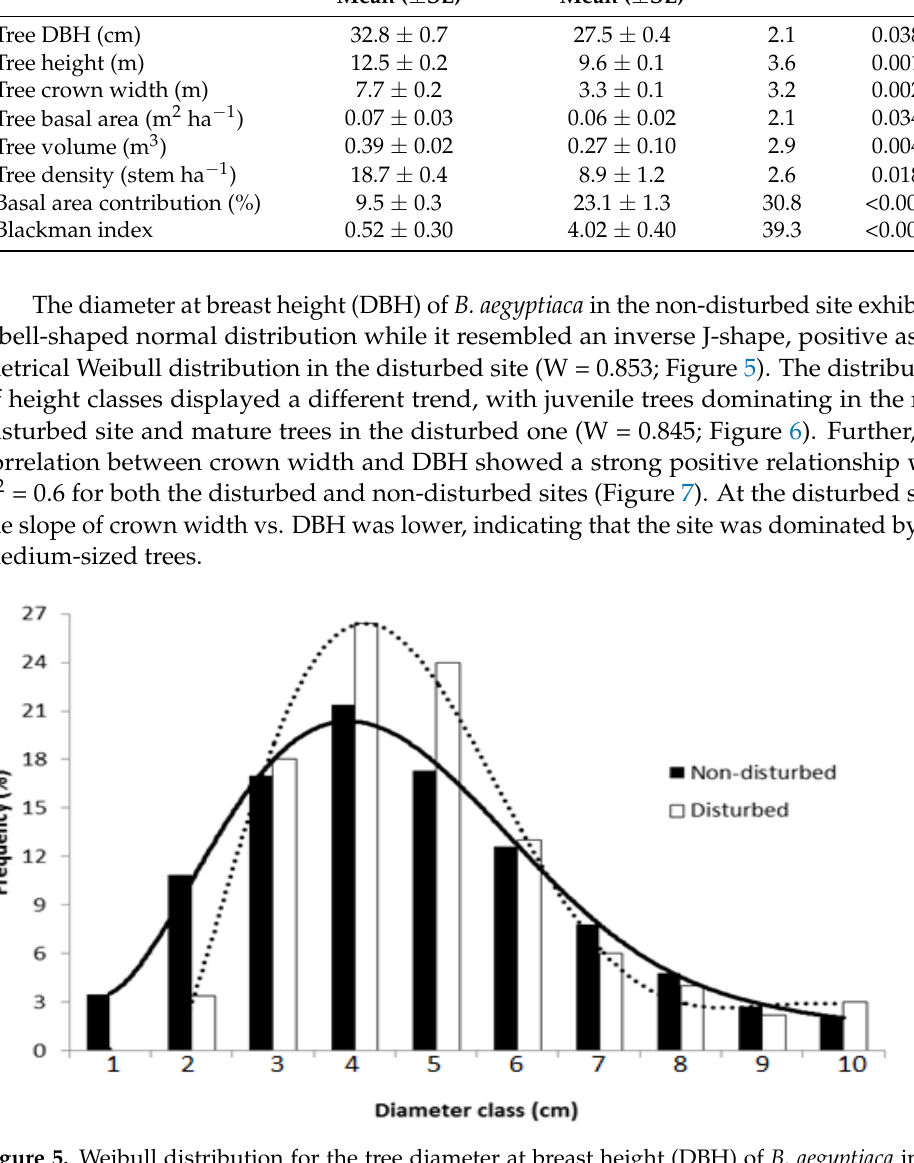
Figure 5. Weibull distribution for the tree diameter at breast height (DBH) of B. aegyptiaca in the non-disturbed and disturbed sites at the Dinder Biosphere Reserve, Sudan, along increasing DBH categories. Classes: 1 = 6–10 cm, 2 = 11–15 cm, 3 = 16–20 cm, 4 = 21–25 cm, 5 = 26–30 cm, 6 = 31–35 cm, 7 = 36–40 cm, 8 = 41–45 cm, 9 = 46–50 cm, 10 = 51–55 cm, and n = 545.